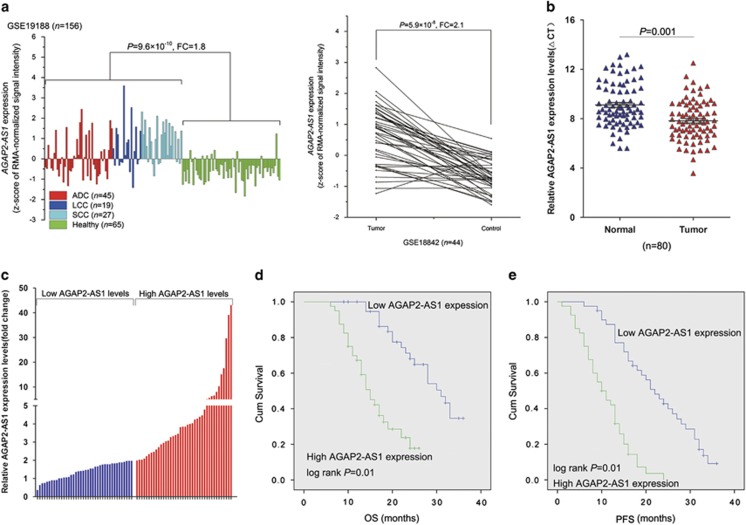
Relative AGAP2-AS1 expression in NSCLC tissues and its clinical significance. (a) Relative expression of AGAP2-AS1 in NSCLC tissues compared with normal tissue was analyzed by using Gene Expression Omnibus data sets GSE18842 and GSE19188. (b) Relative expression of AGAP2-AS1 in NSCLC tissues (n=80) compared with corresponding non-tumor tissues (n=80) was examined by qPCR and normalized to GAPDH expression. Results were presented as the delta CT value. Data are presented as mean±s.e.m. (c) AGAP2-AS1 expression was classified into two groups according to the median value of AGAP2-AS1 expression level in NSCLC tissues sample. (d and e) Kaplan–Meier method with the log-rank test was used to analyze the overall survival and progression-free survival curves of patients in high and low AGAP2-AS1 expression groups